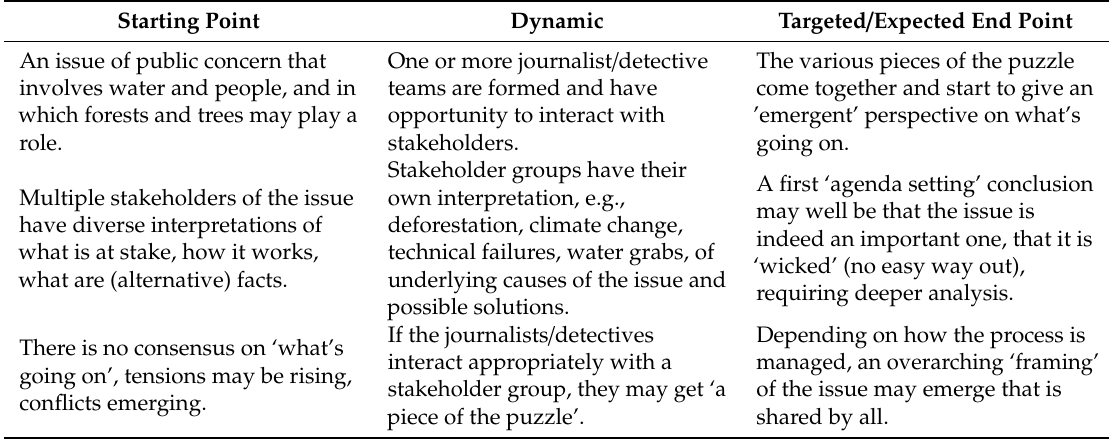
Figure 10. Initial game typology based on scope (A for agenda setting, B for better understanding land-use decisions, C for consequences of land-use decisions for water flows, D. for driver level responses by stakeholders external to the landscape considered in B). Table 4. Prototype of ‘What’s going on’ agenda-setting game (journalist/detective quest), with targeted/expected endpoints as hypothesis for further corroboration; type A in Figure 10.